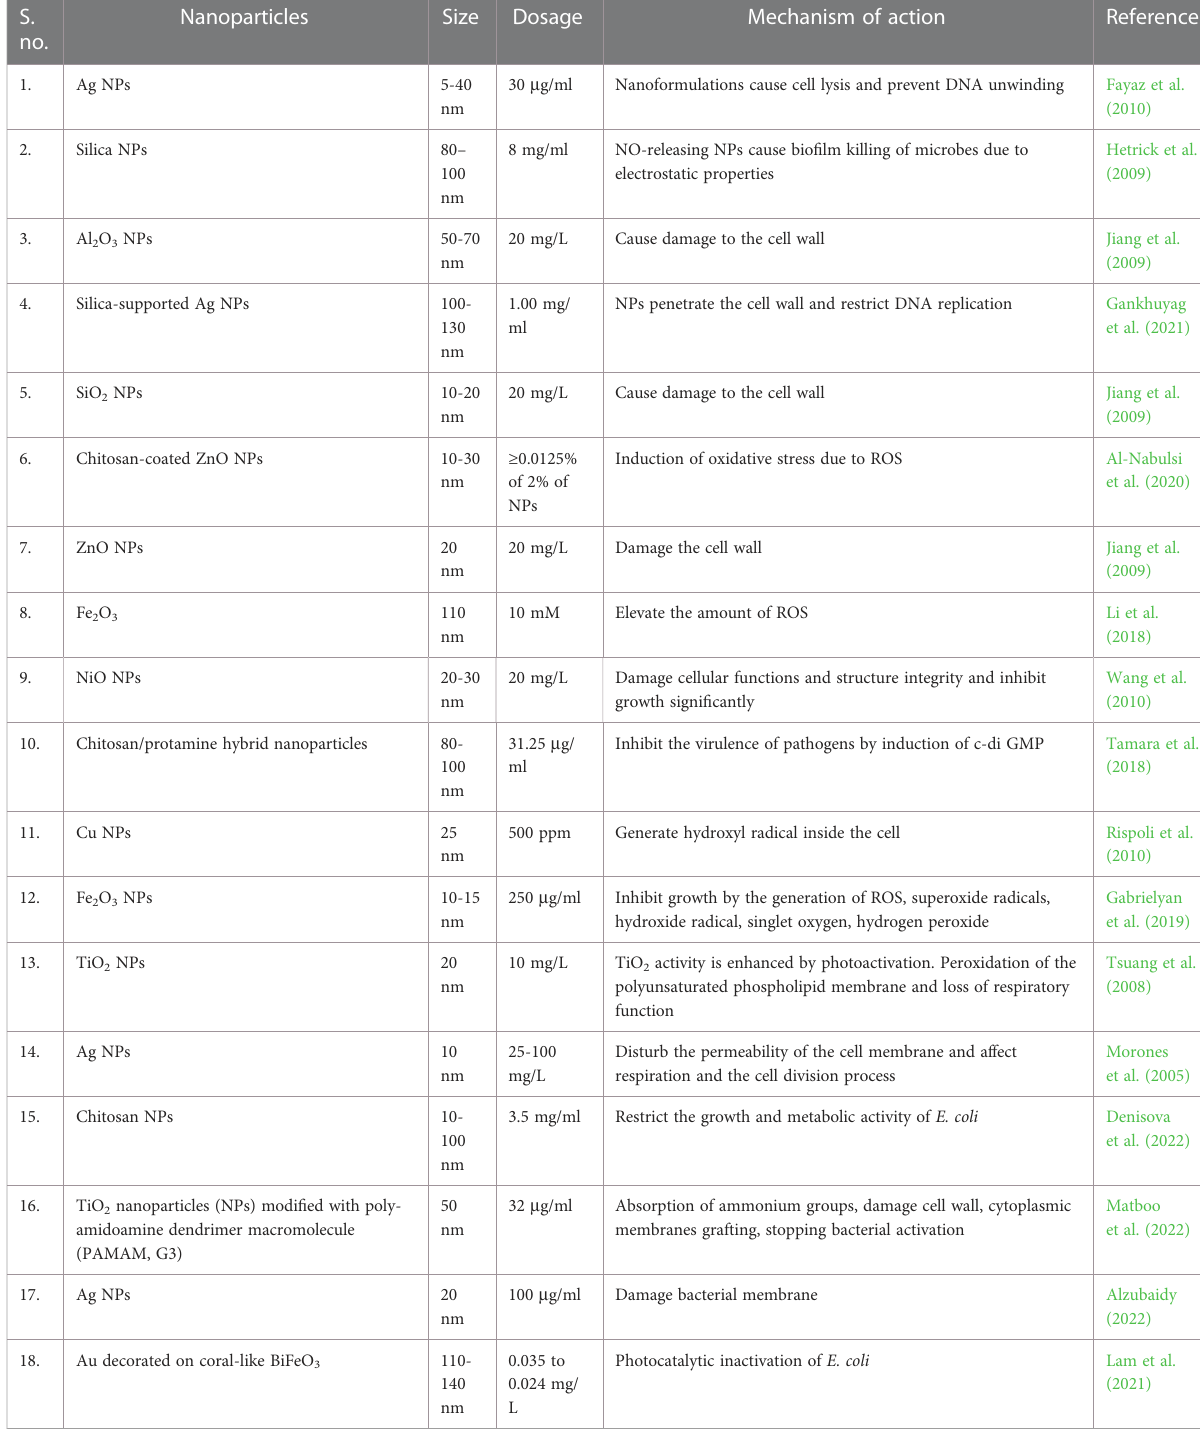
TABLE 2 Different nanostructured materials and their toxic effects in Escherichia coli